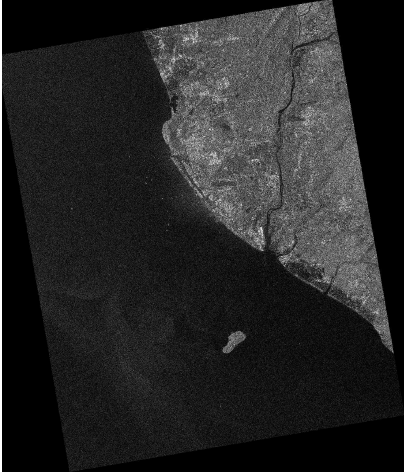
Figure 9. RADARSAT-1 image (Kaohsiung, Taiwan, acquired by RADARSAT-1 in FINE mode).